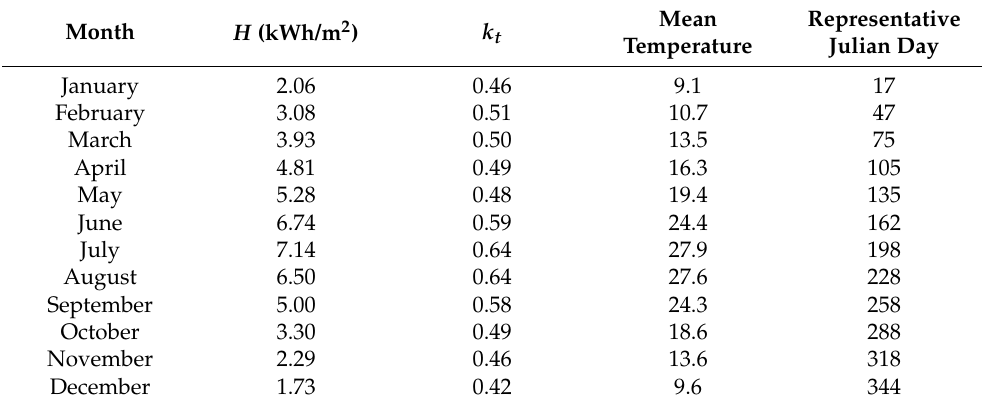
Table 2. Daily radiation on the horizontal plane ( H ) and ( k t ) in C ó rdoba (Spain) [19] and representa- tive day of each month